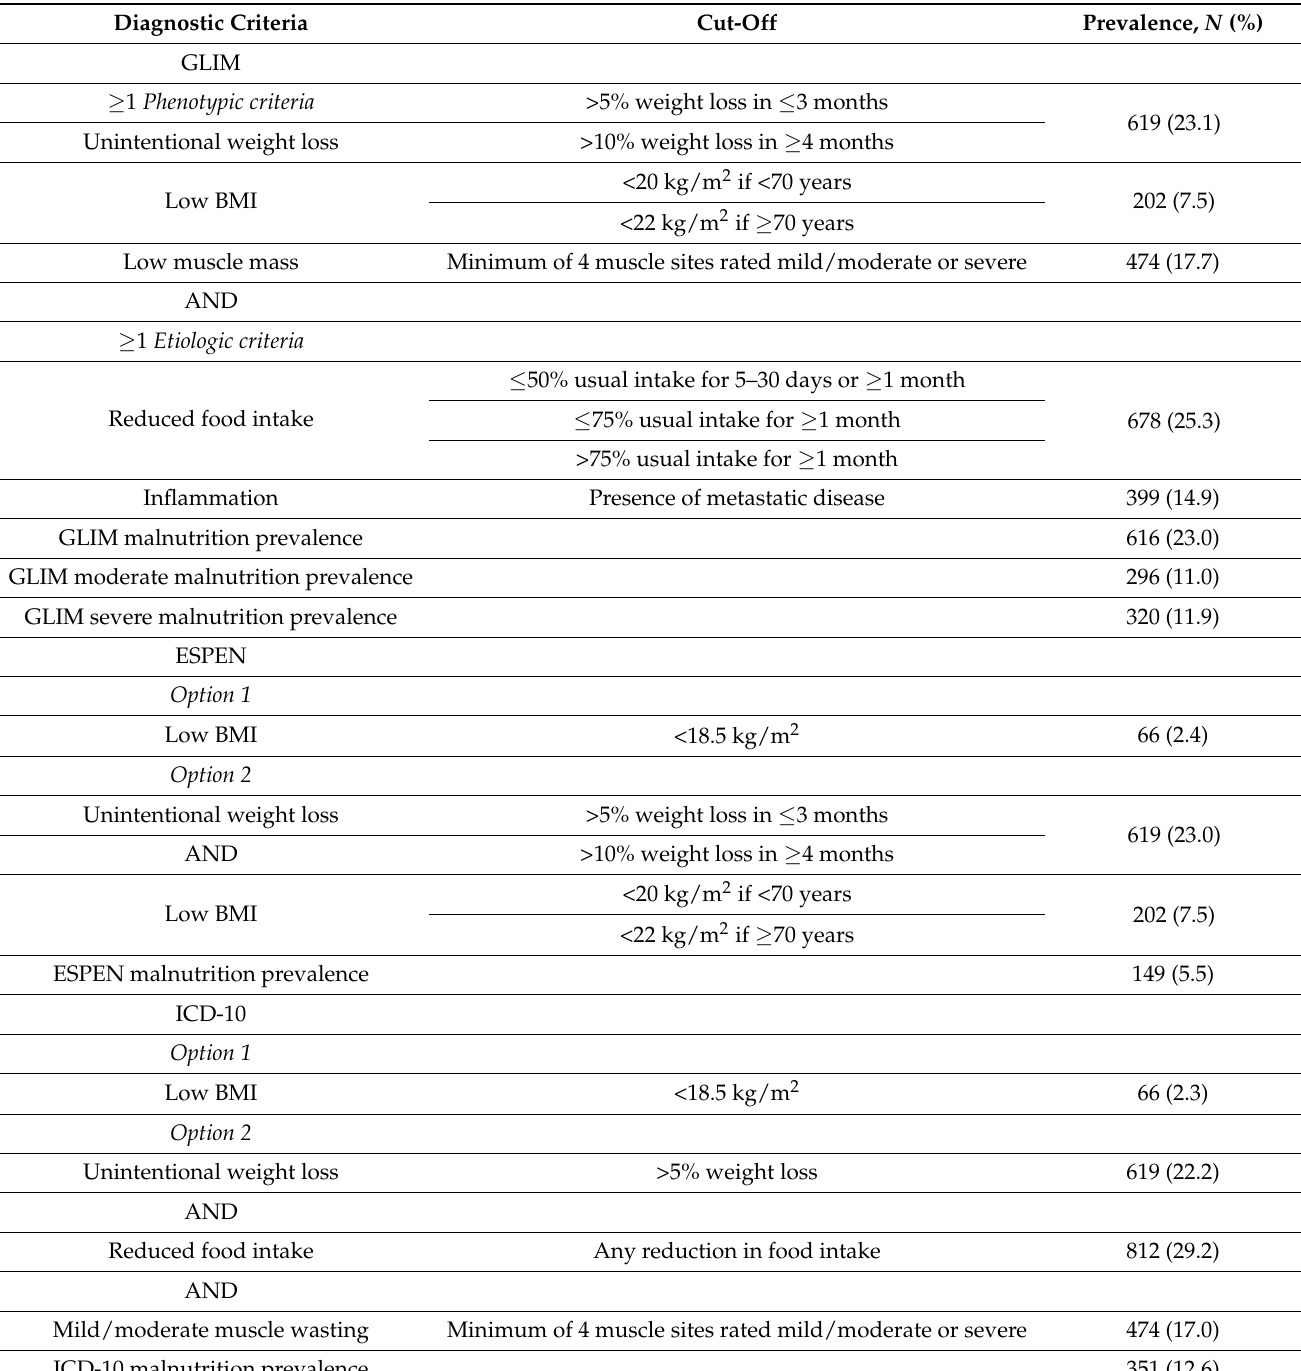
Table 2. Malnutrition prevalence and assessment criteria according to GLIM, ESPEN and ICD-10 diagnostic criteria ( N =